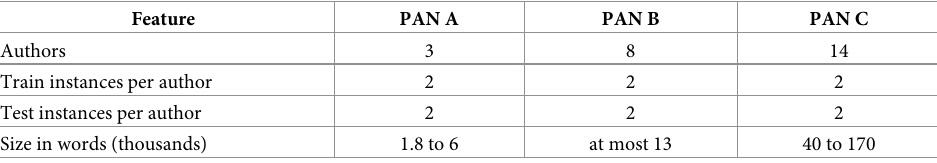
Table 2. PAN/CLEF 2012 benchmark